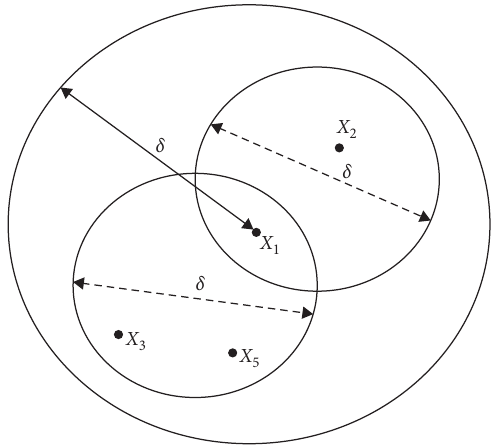
Figure 5: Data information processing in multi-pointer